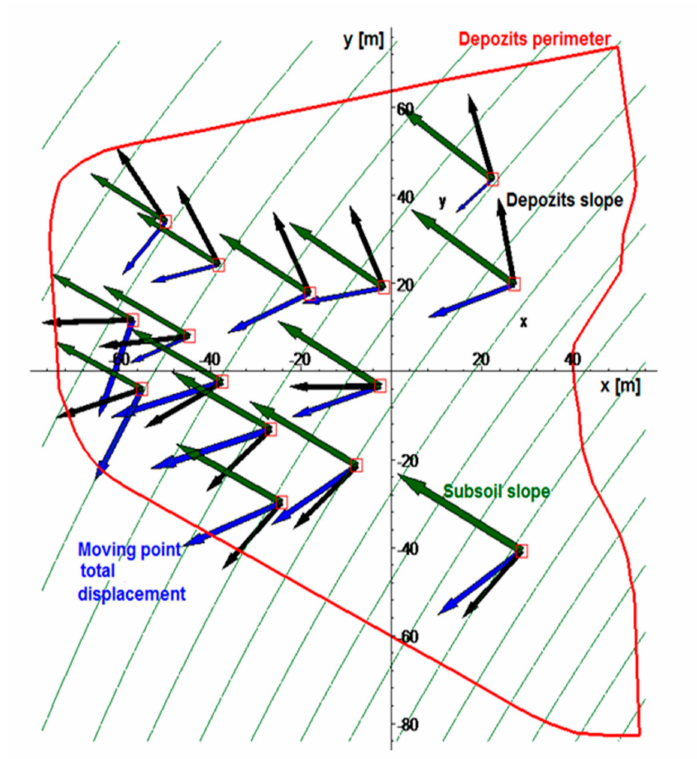
Figure 10. Measuring point displacement directions in reference to inclination of the landfill and deposit